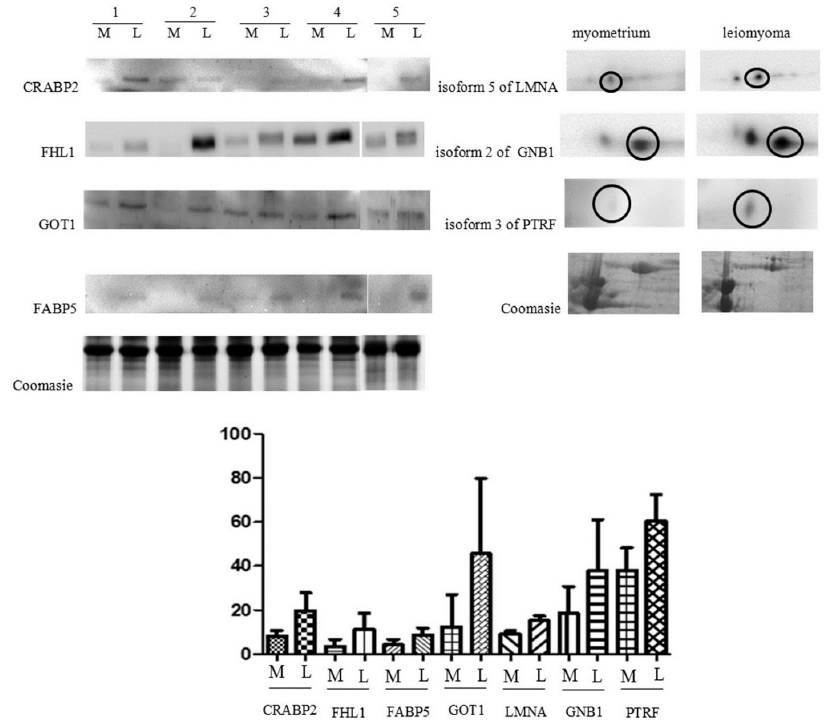
Figure 2. Western blot analysis of CRABP2, FHL1, FABP5, GOT1, isoform 5 of LMNA, isoform 2 of GNB1 and isoform 3 of PTRF in paired myometrium (M) and leiomyoma (L). The isoform corresponding to the one identified by 2-DE is circled. The intensity of immunostained bands was normalized against the total protein intensities measured from the same blot stained with Coomassie brilliant blue. The bar graph shows the relative expression (band density) of proteins in the myometrium and the leiomyoma. The results are shown as a histogram (mean) with whiskers representing the standard deviation. All differences were found to be significant (Wilcoxon signed-rank test for matched samples, p < 0.05).